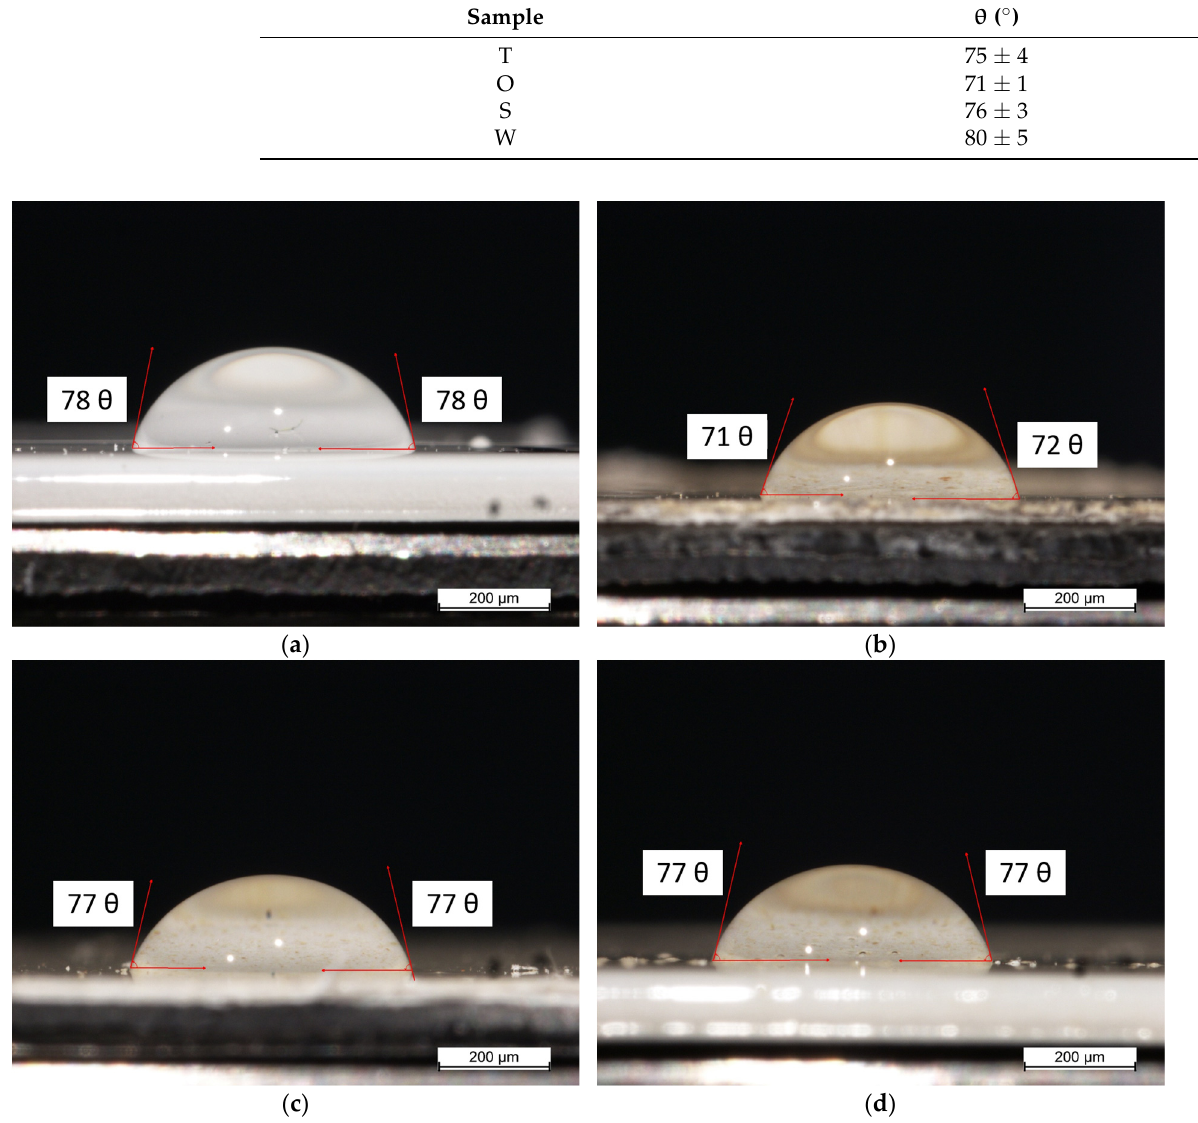
Figure 8. Contact angle measurements of ( a ) sample T, ( b ) sample O, ( c ) sample S, and ( d ) sample W.